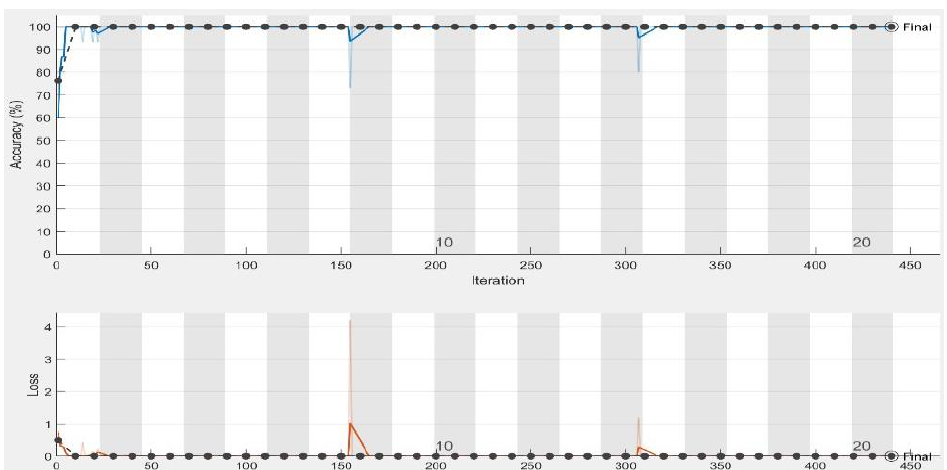
Figure 7. GoogLeNet training process with learning rate of 0.0001. The figure shows the epoch number, training accuracy (blue line), validation accuracy (black line), and loss function value for the training data (red line) and validation data (black line).